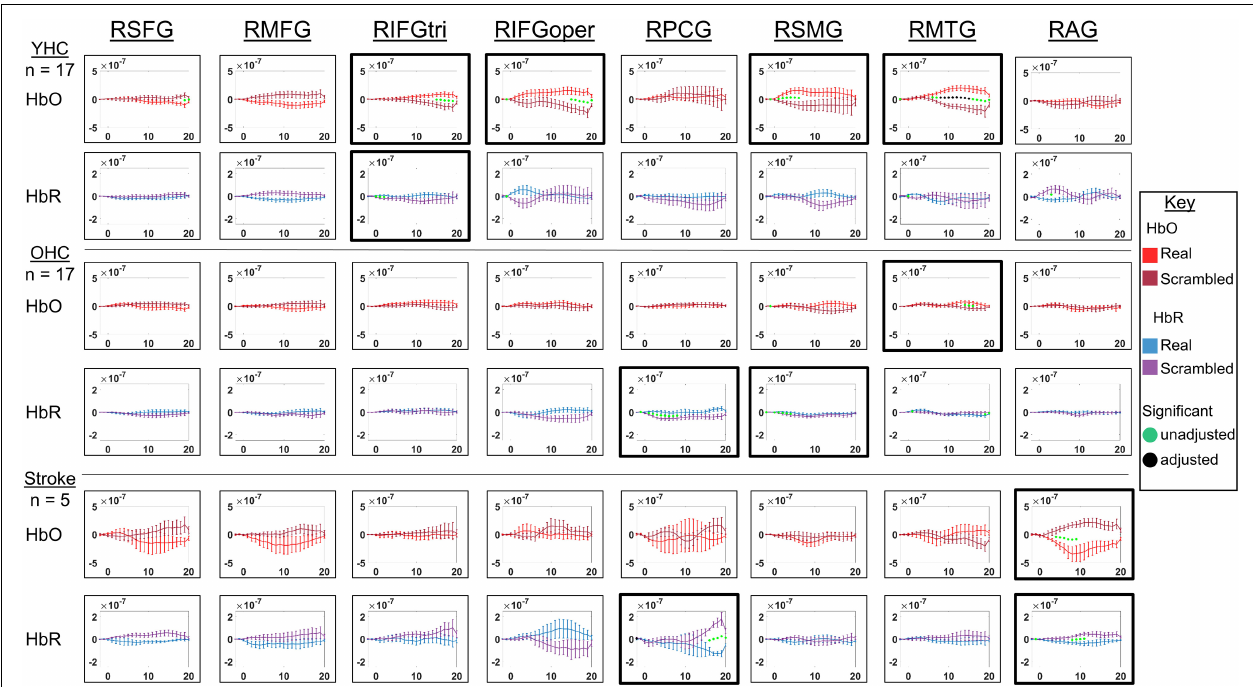
FIGURE 8 | Comparison of group average HRF between task conditions for right hemisphere ROIs during picture naming. HbO and HbR changes in µ M units. Significant difference between task conditions at p < 0.05 level are reflected by a green dot and after FDR-adjustment with alpha of 0.05 by a black dot. Black borders denote ROIs for which there was a significant difference between the task conditions for at least three consecutive seconds. When the red line is higher than the maroon line, it suggests there was greater HbO concentration change in the real than scrambled picture condition. When the blue line is lower than the purple line, it suggests there was lower HbR concentration change in the real than scrambled picture condition. Both patterns are consistent with greater neural activation (i.e., increase in oxygenated blood, decrease in deoxygenated blood) in the real than scrambled picture condition and vice versa. RSFG, right superior frontal gyrus; RMFG, right middle frontal gyrus; RIFGtri, right inferior frontal gyrus pars triangularis; RIFGoper, right inferior frontal gyrus pars opercularis; RPCG, right precentral gyrus; RSMG, right supramarginal gyrus; RAG, right angular gyrus; YHC, younger healthy controls; OHC, older healthy controls; HbO, oxygenated hemoglobin concentration change; HbR, deoxygenated hemoglobin concentration